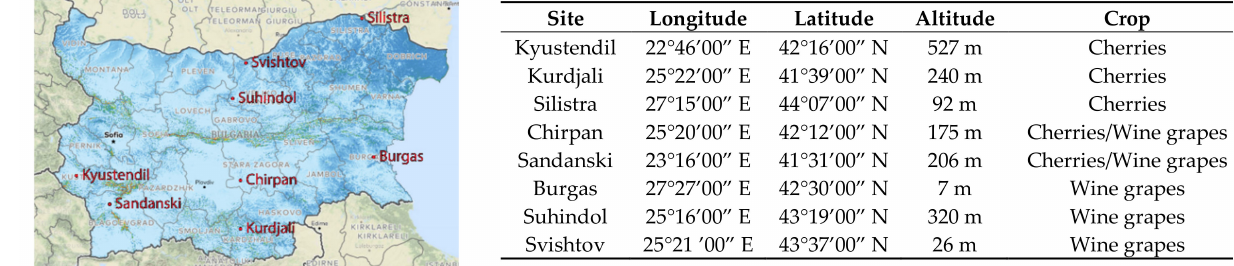
Figure 6. Considered sites: geographical position, coordinates and respective crops.